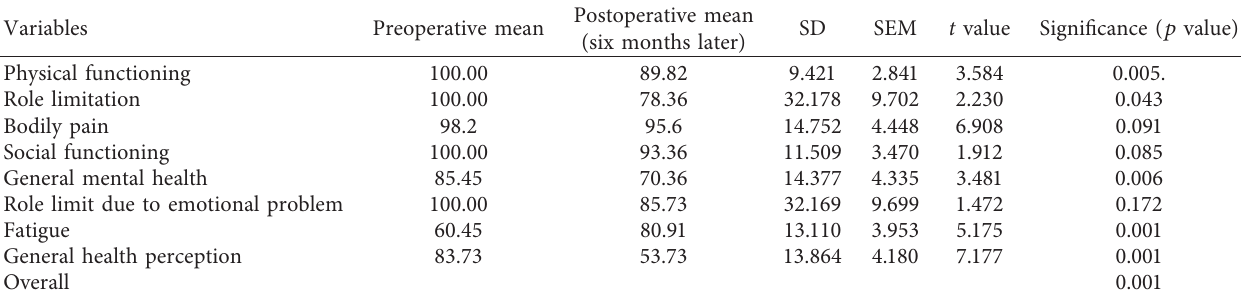
Table 4: Summary of SF-36